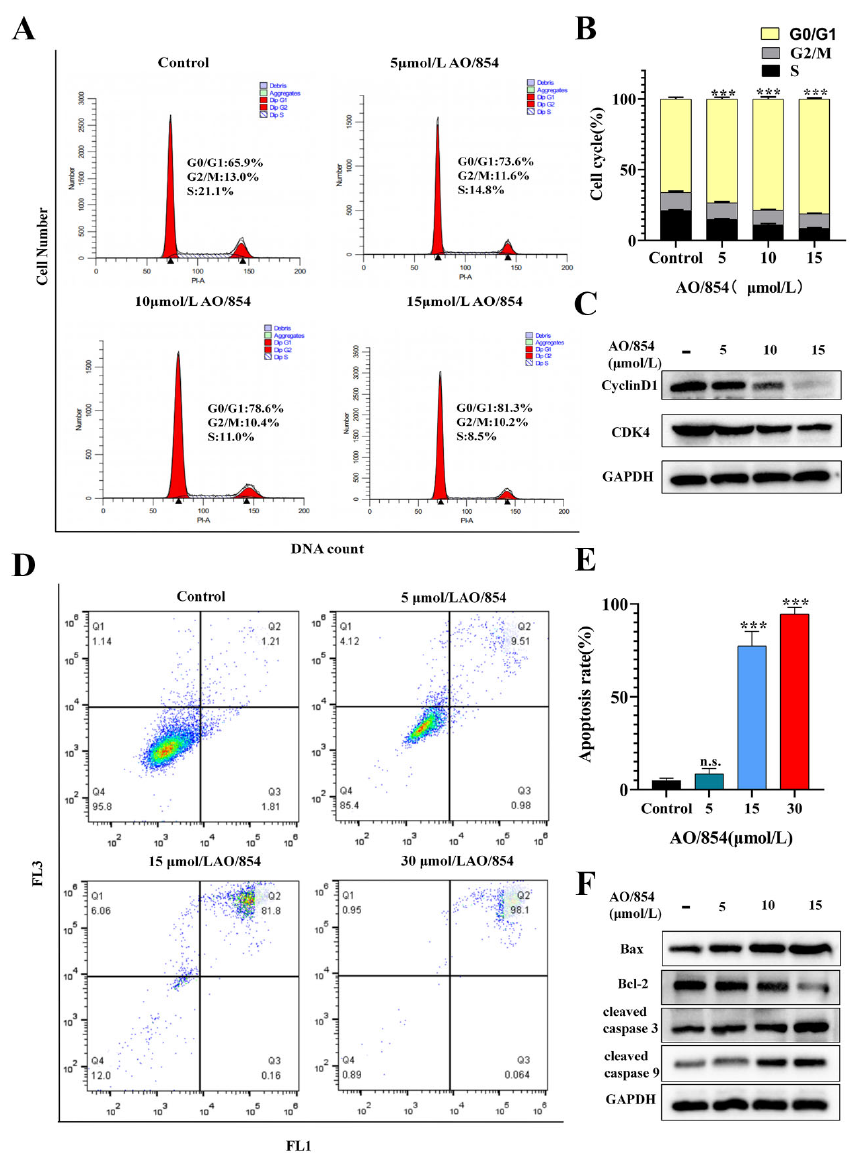
Figure 6. AO/854-induced cell cycle arrest and cell apoptosis in PC3 cells. ( A ) Cell cycle analysis for control, AO/854 (5, 10, and 15 µ mol/L) treatment on PC3 cells. ( B ) Quantification of cell cycle experiments in AO/854 (5, 10, and 15 µ mol/L)-treated groups compared with DMSO-treated group (control group). (*** p < 0.001). ( C ) Protein levels of CDK4 and CyclinD1 as detected by western blotting after being treated with AO/854 (5, 10, and 15 µ mol/L) for 48 h. GAPDH was examined as a loading control. ( D ) Cell apoptosis analysis for control, AO/854 (5, 15, and 30 µ mol/L) treatment on PC3 cells. ( E ) Quantification of cell apoptosis experiments in AO/854 (5, 10, and 15 µ mol/L)- treated groups compared with DMSO-treated group (control group) (n.s. p > 0.05, *** p < 0.001). ( F ) Protein levels of Bax, Bcl-2, cleaved caspase 3, and cleaved caspase 9 as detected by western blotting after being treated with AO/854 (5, 10, and 15 µ mol/L) for 48 h. GAPDH was examined as a loading